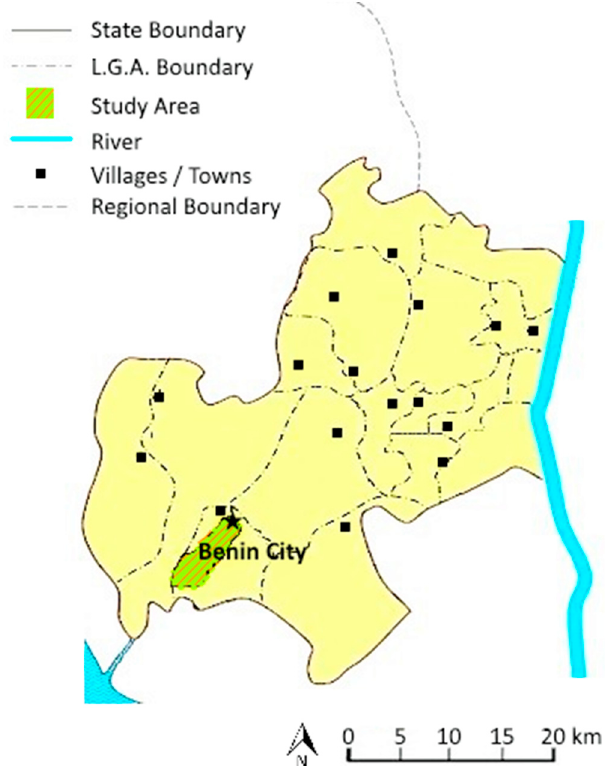
Figure 1. Map of Edo State [13].